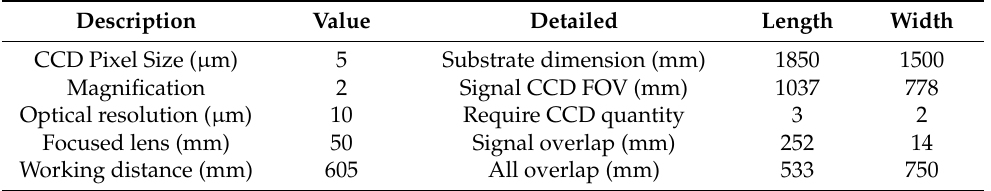
Figure 3. The architecture of the optical detection system comprising ( A ) of CF at (1) glass-in, (2) CCD detection, (3) exposure machine, (4) glass-out; below diagram ( B ) of TFT includes (1) glass-in, (2) laser optic scanning, (3) array check system, and (4) glass-out. Table 1. The parameters for optical detection of the debris on the color filter.